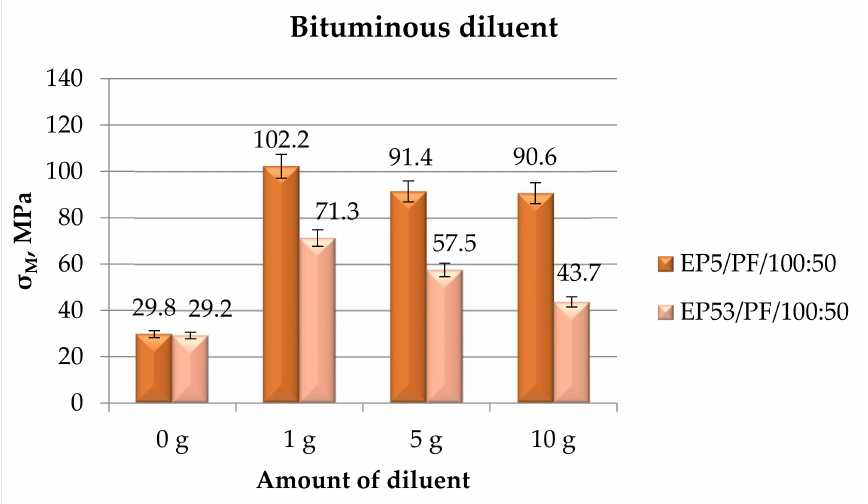
Figure 11. Compressive strength calculated for Epidian 5 and Epidian 53 epoxy compounds as a function of the amount of bituminous diluent.